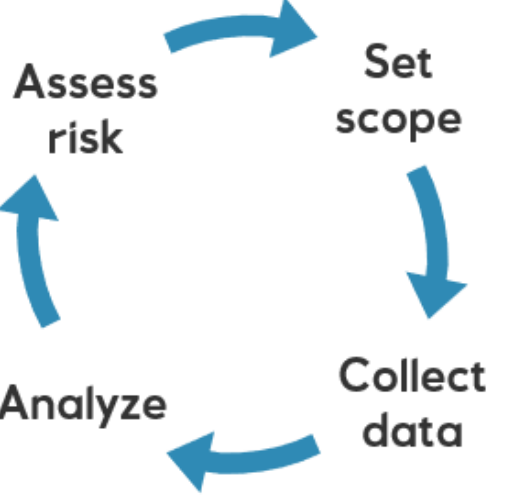
Figure 1. In a risk-based and flexible GCS monitoring strategy, an initial monitoring scope is based on available information, and adjusted continuously as new information becomes